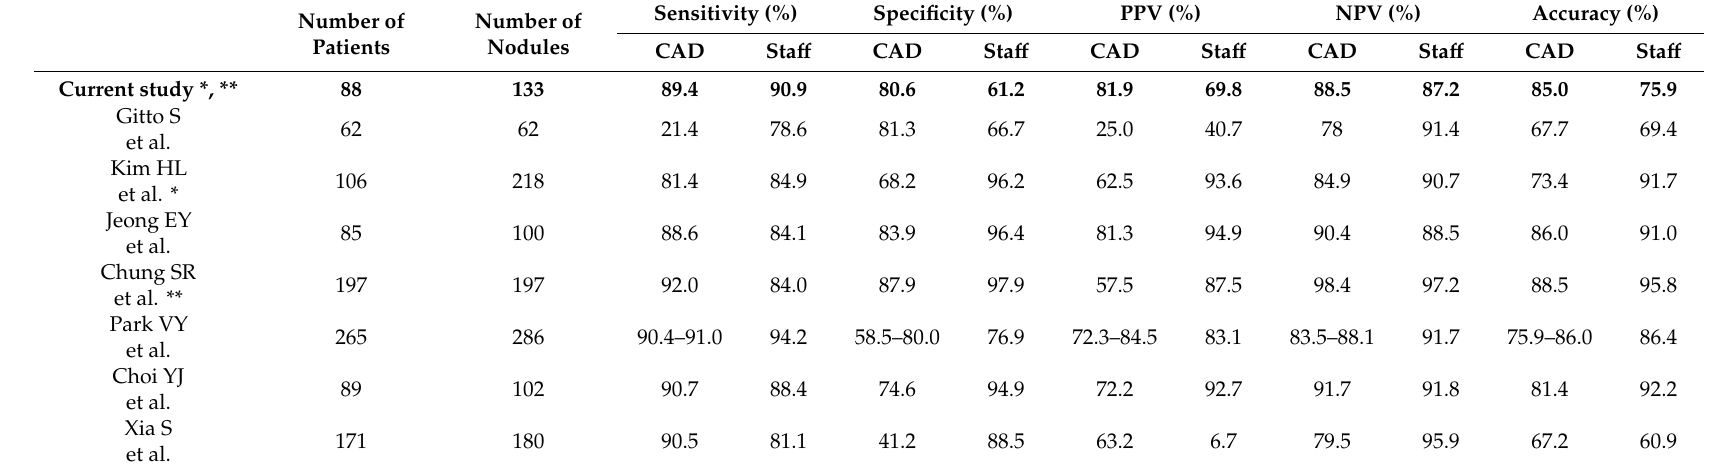
Table 3. Comparison of diagnostic performance of the computer-aided diagnosis (CAD) system and experienced sta ff . Number of